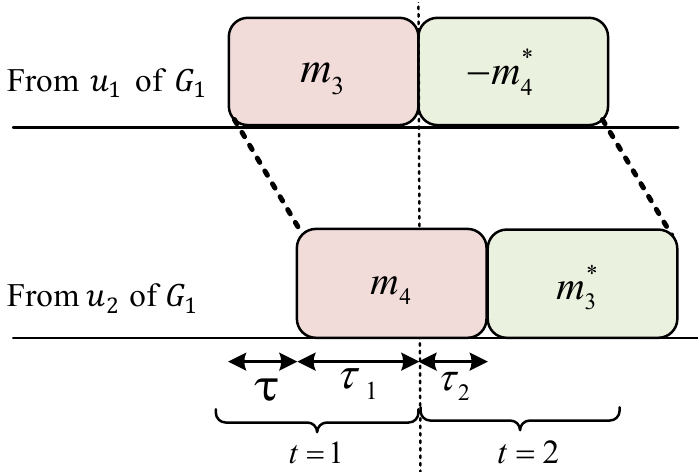
Figure 2. Timing diagram for STBC cooperation with timing offset ( τ